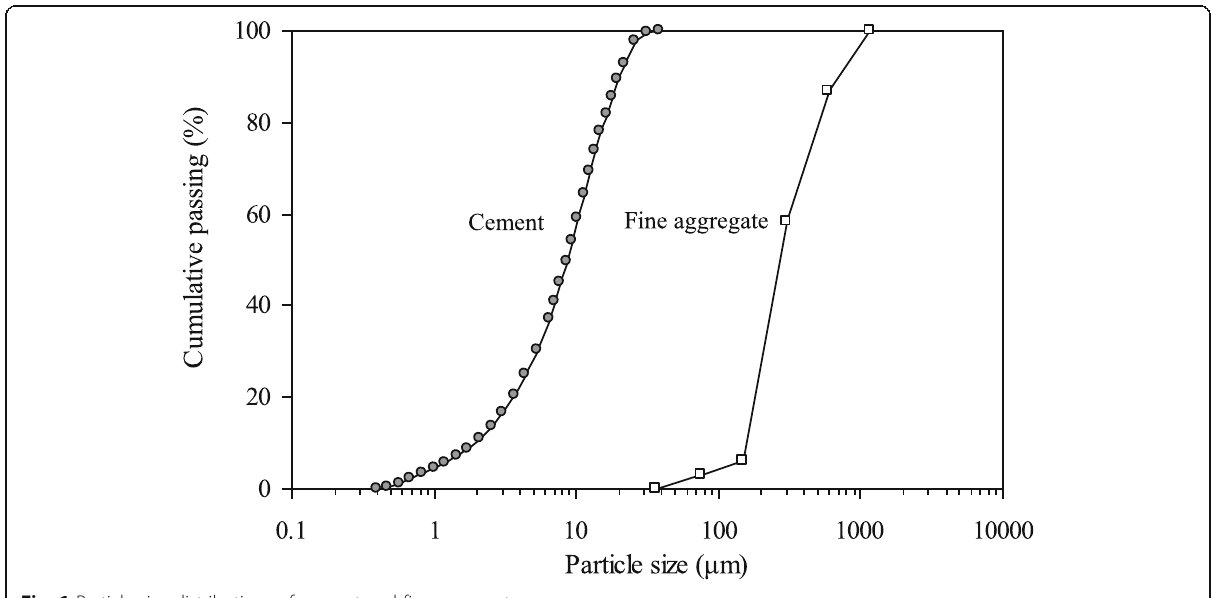
Fig. 1 Particle size distributions of cement and fine aggregate